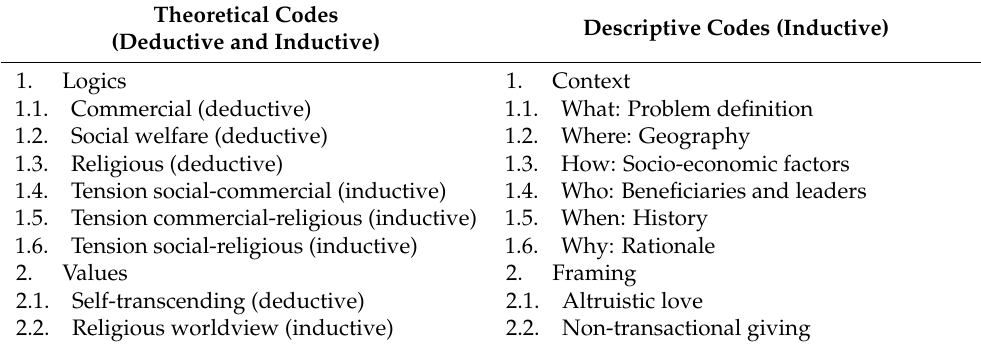
Table 2. Thematic